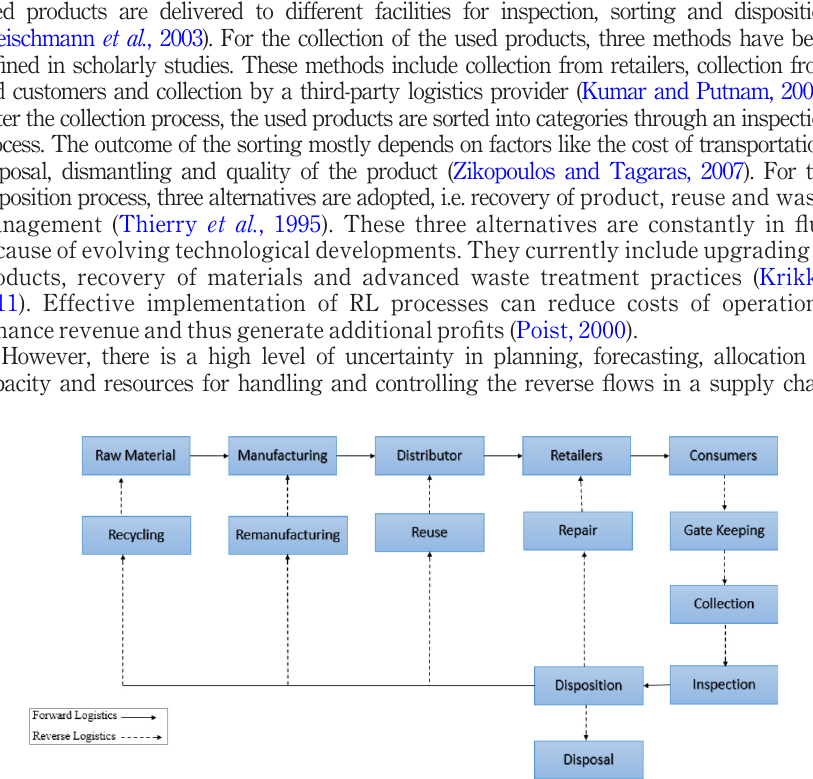
Figure 1. Basic fl ow of reverse and forward